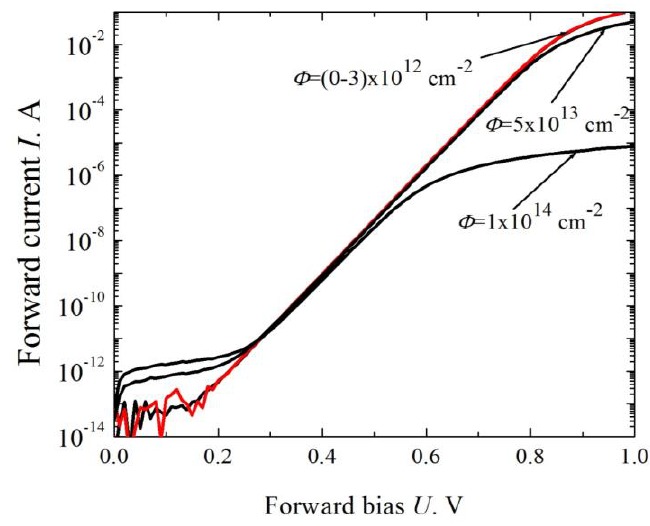
Figure 6. Forward current-voltage characteristic of a Schottky diode (1200 V class) at various doses of irradiation with 15 MeV protons [36].